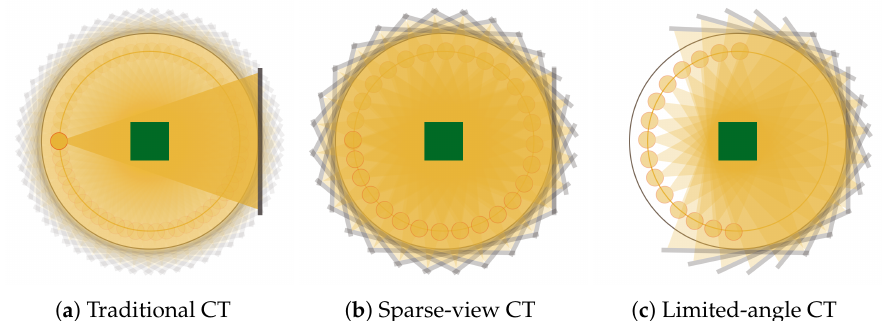
Figure 1. The three different CT geometric protocols. In the traditional setting ( a ), the X-ray source and the detector walk a full circle trajectory with a very small angular step, which is enlarged in sparse-view CT ( b ), whereas in limited-angle CT ( c ), the source-detector rotation is restricted to a C-shape path.